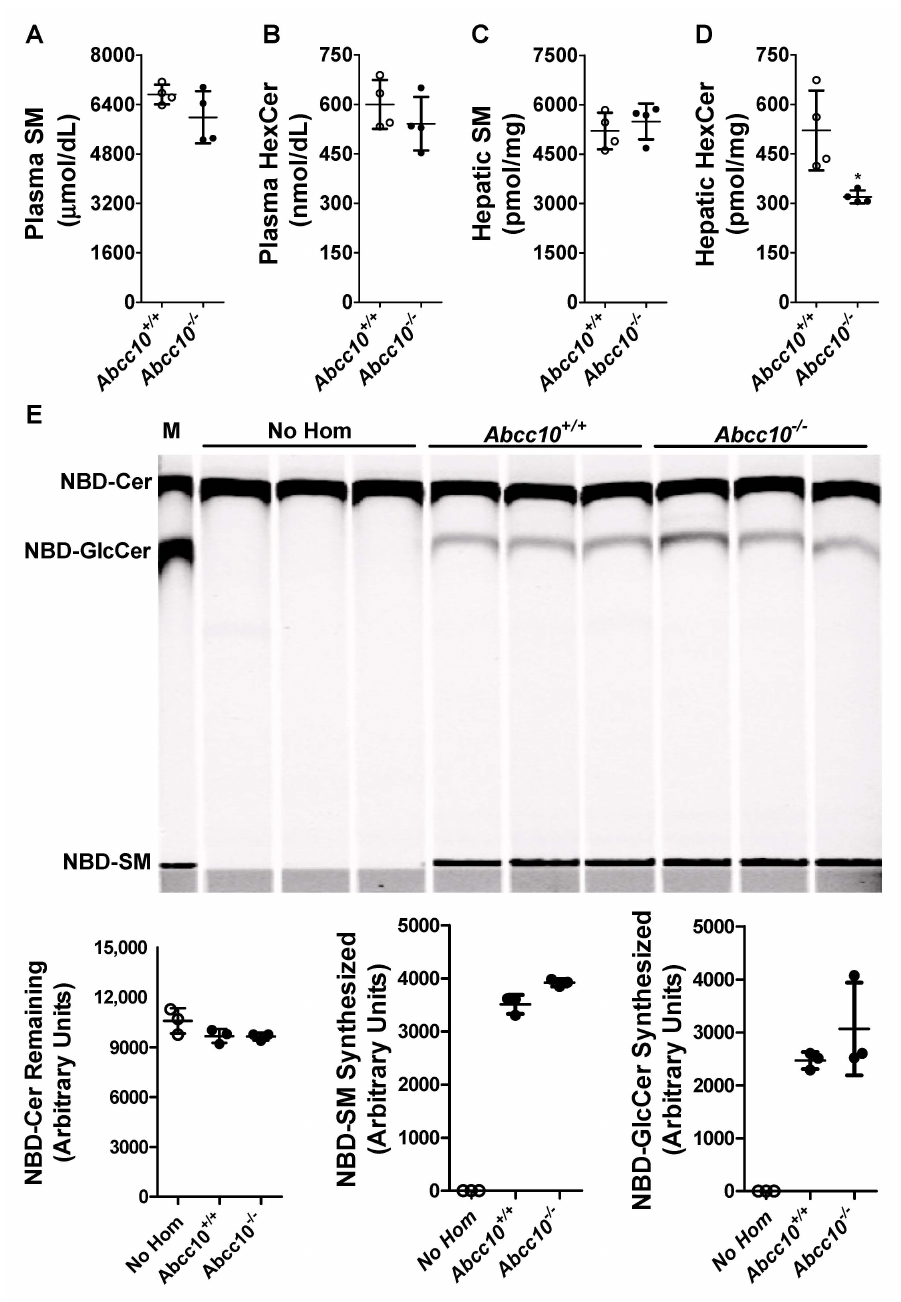
Figure 5. ABCC10 in hepatic HexCer metabolism. ( A – D ) Deletion of Abcc10 gene in mice reduces liver HexCer levels. Overnight fasted Abcc10 +/+ and Abcc10 − / − mice ( n = 4, 12-week-old, chow fed) were used to measure plasma ( A , B ) and liver ( C , D ) SM and HexCer levels. Values are replicates (Mean ± SD). * p < 0.05 compared with Abcc10 +/+ mice. ( E ) Ablation of ABCC10 does not affect glucosylceramide synthase activity in liver homogenates. Abcc10 +/+ and Abcc10 − / − liver homogenates (500 µ g protein) were incubated ( n = 3) with phosphatidylcholine (100 µ g/mL), C6-NBD ceramides (3.3 µ g/mL) and UDP-glucose (500 µ M) at 37 ◦ C for 1 h. As a control, reaction was also carried out in triplicate without the addition of any protein homogenates (No Hom). Lipids were extracted from the reaction mixtures, separated on TLC, fluorescence in Cer, SM, and GlcCer bands were scanned using PhosphorImager ( top ), and quantified by Image J ( bottom ). Values are plotted as replicates (Mean ± SD). In lane “M”, NBD-labeled lipids were used to identify different